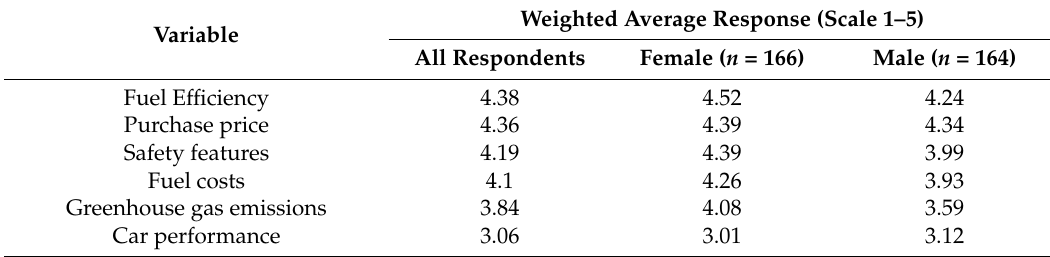
Figure 1. Importance of key vehicle attributes when buying any car shown as Weighted Average Responses with 5 as a maximum value. Table 2. Importance of key vehicle attributes when buying any car (Questionnaire 1: Question 26) ( n =